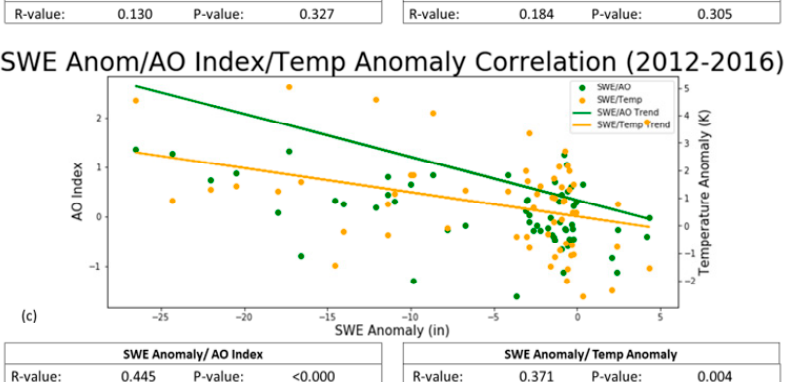
Figure 8. Scatter plot and regression lines for the northern California SWE anomaly as compared to the 3-month average AO index (green) and 850 hPa temperature anomaly (orange) for the three different time periods (1988–1992, 2002–2006, and 2012–2016) highlighted in yellow shadings in Figure 7. The correlation coefficients and their statistical significance for each subplot are provided in the